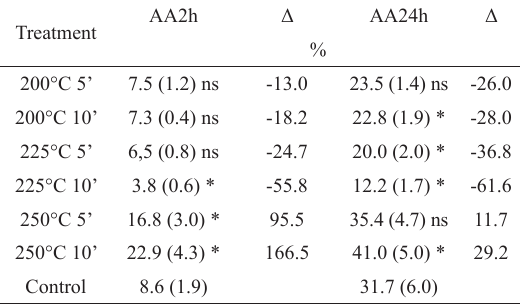
Table 3: Average values water absorption values of the MDF after two and twenty-four hours of immersion.